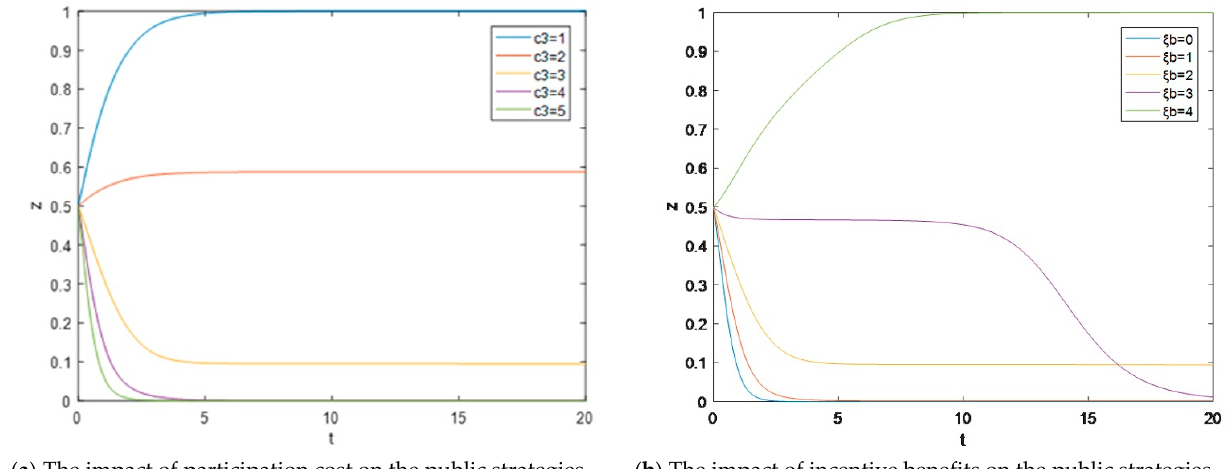
Figure 15. The impact of both the benefit from rent-seeking behaviors and accountability or punish- ment on local government’s strategies.